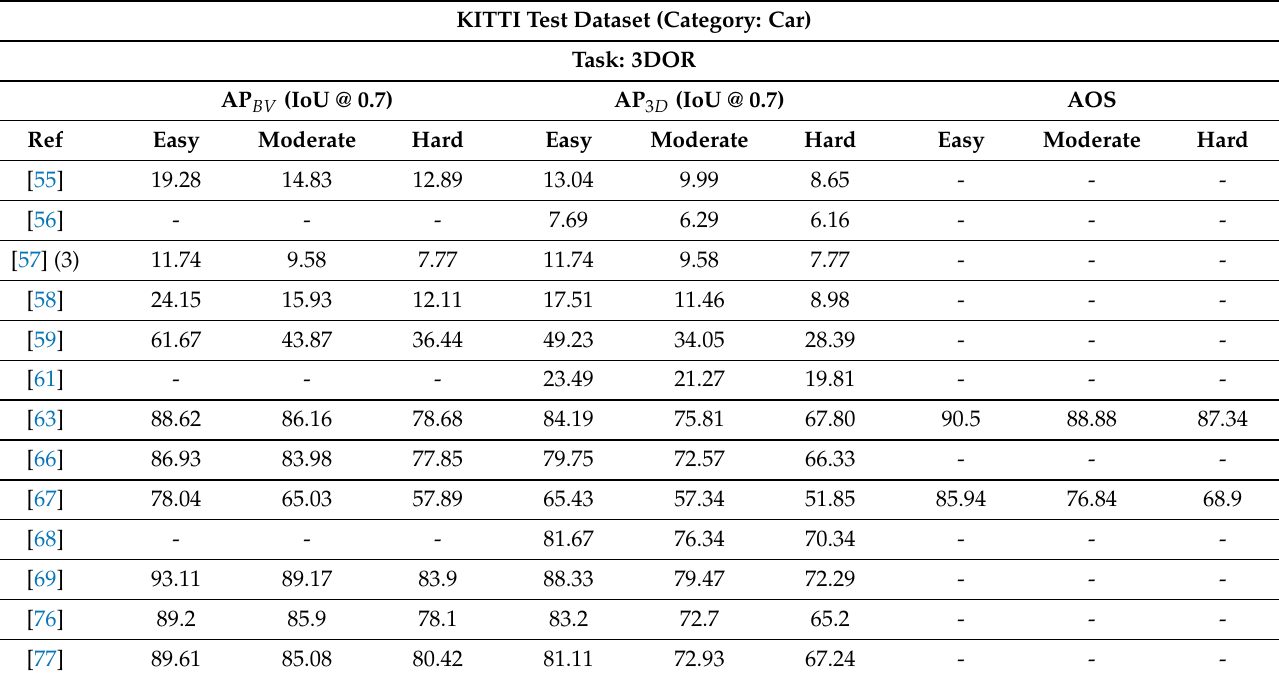
Table 22. Comparison of the Results on the KITTI Test Dataset for the Car Category.